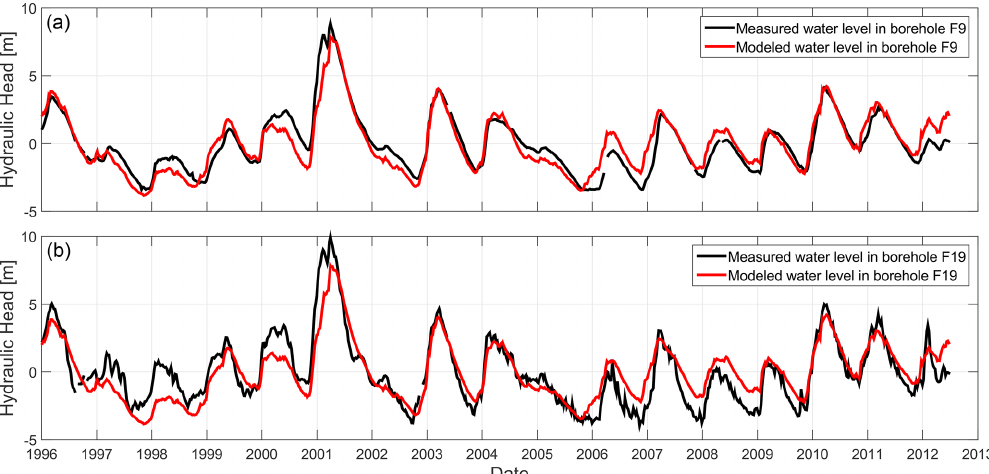
Figure 5. Comparison between best modeled and observed water table fluctuations at borehole F9 (a) and F19 (b) , respectively at 519 and 268m of Ploemeur’s pumping wells. Hydraulic parameters correspond to best parameters (lowest RMSE in Fig. 6 regarding water table fluctuations). Prescribed recharge fluctuations have a negligible impact on these parameters and the quality of the fit.